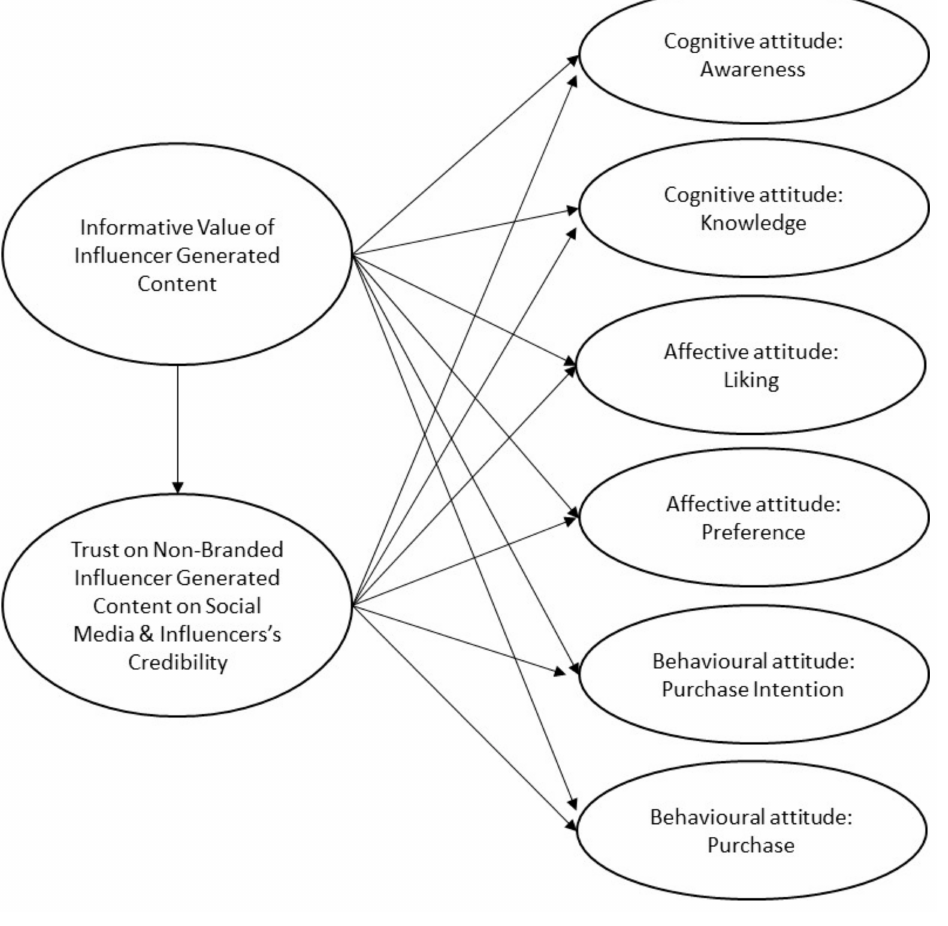
Figure 1. Theoretical